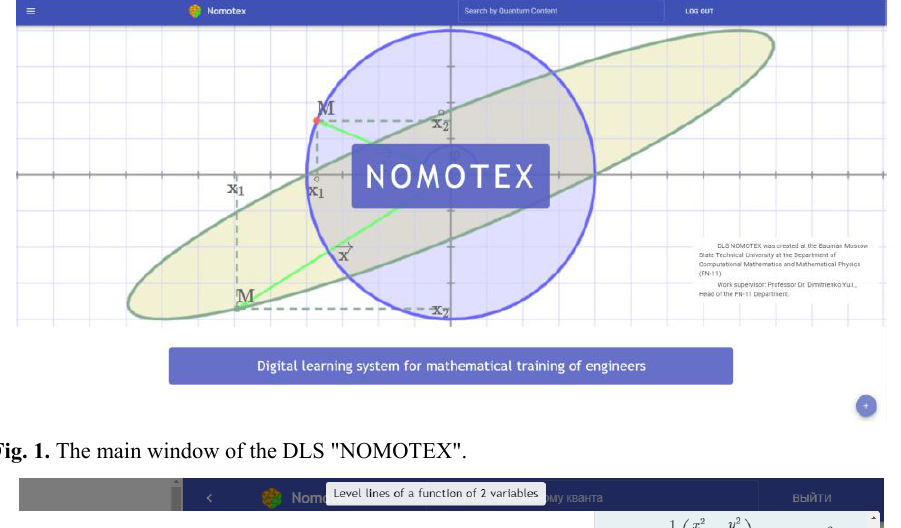
Fig. 1. The main window of the DLS "NOMOTEX".